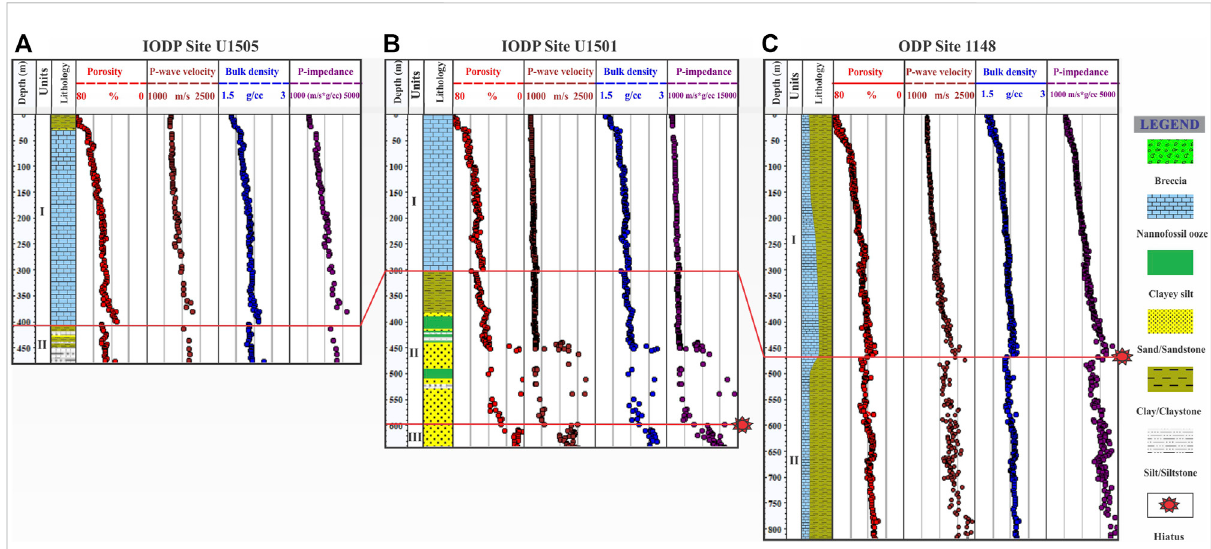
Core data results of the studied sites U1501, U1505, and U1148 and the position of non-depositional hiatus, with measurements of moisture, density(MAD),P-wavevelocity(PWC),andPimpedance. (A) DatafromIODPsiteU1505; (B) DatafromIODPsiteU1501; (C)